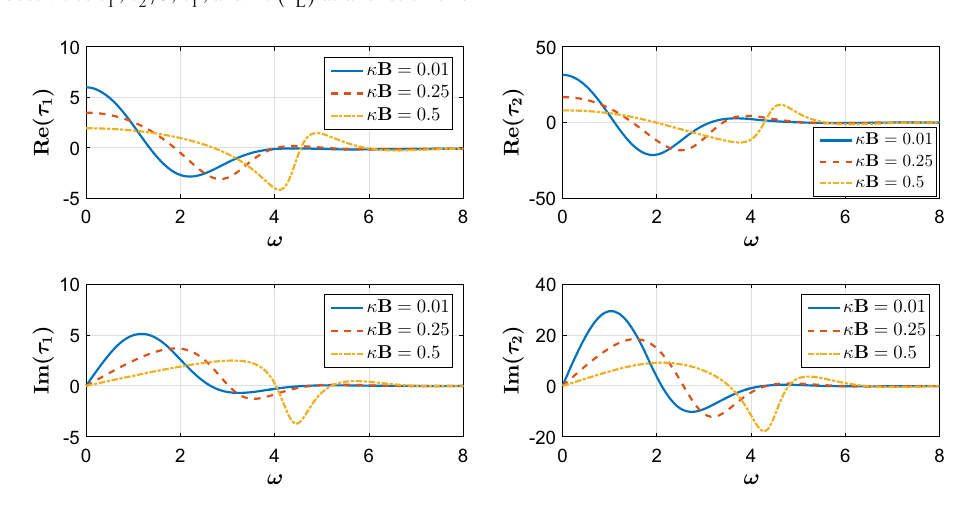
Fig. 2 AC conductivities τ 1 and τ 2 for different values of κ B